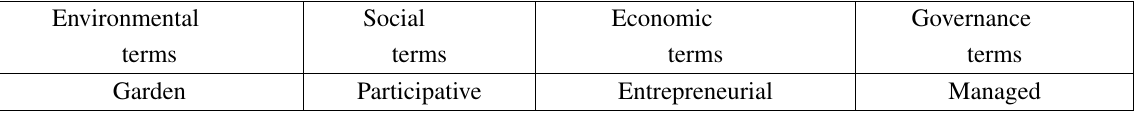
Table 1. Elements, terms and conceptions of